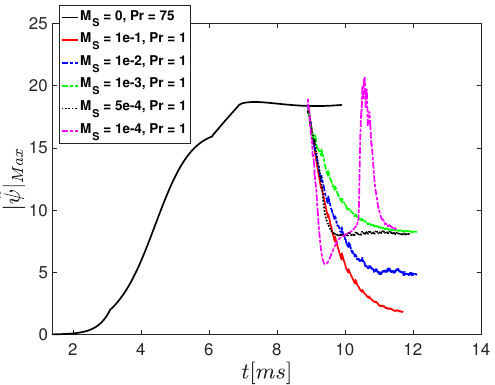
Figure 5. Time evolutions of the | ˜ ψ | Max for (2,1) mode for Pr = 75 (black solid line) and Pr = 1 (all other lines), for various levels of the amplitude of the stochastic ZFs, M S .